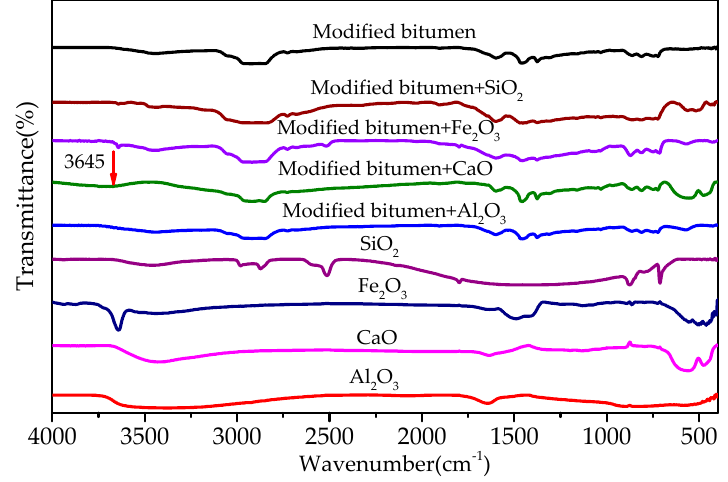
Figure 8. FT-IR results of mixtures of modified bitumen and chemical components of steel slag.